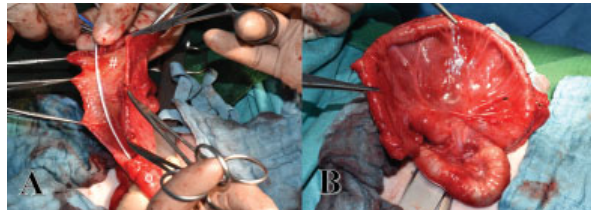
Fig. 2 ( A ) First revisional laparotomy on the 29th day of life. Opening of the megaduodenum, nasogastric tube is bridging the lumen to the following small bowel. Second part of the duodenum after tapering (#). Distal duodenum (o). ( B ) Reconstructed duodenum and proximal jejunum after